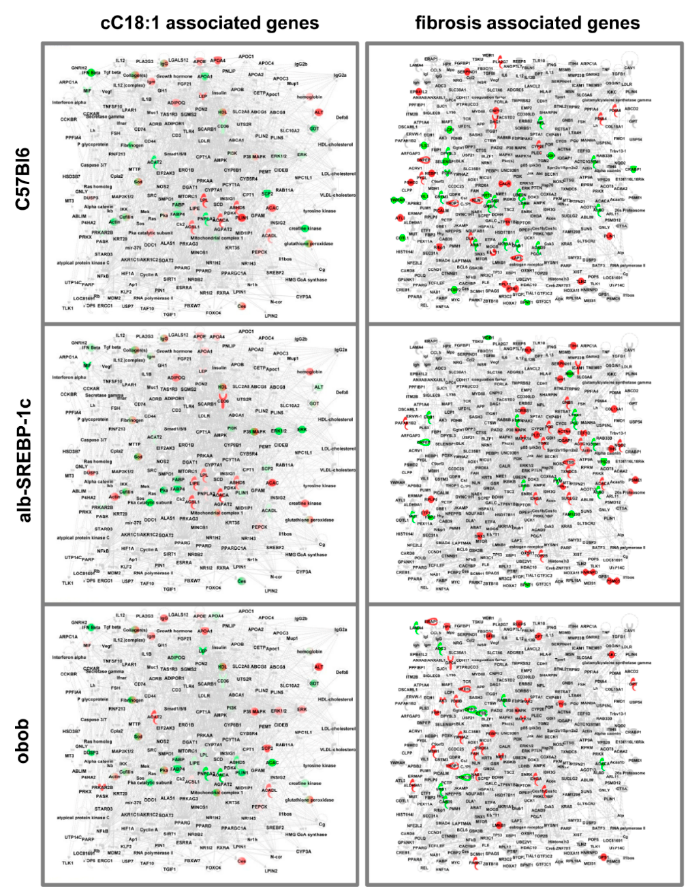
Figure 6. Differential abundance of FA metabolism and steatosis-related proteins in adipokines correlated to the “liver-to-adipose-tissue DNL” ratio. Virtual pathways were generated from proteins related to the keywords to cC18:1 or fibrosis. The proteins that correlated with the “liver-to-adipose-tissue DNL” ratio were used for IPA ® core analyses to extend the information to upstream regulating proteins (Supplementary Materials Table S6). Coloring represents the different abundances in the comparisons of C57Bl6 vs. alb-SREBP-1c, C57Bl6 vs. obob, and alb-SREBP-1c vs. obob. (Red: more abundant; green: less abundant; grey: not regulated in the specific comparison).